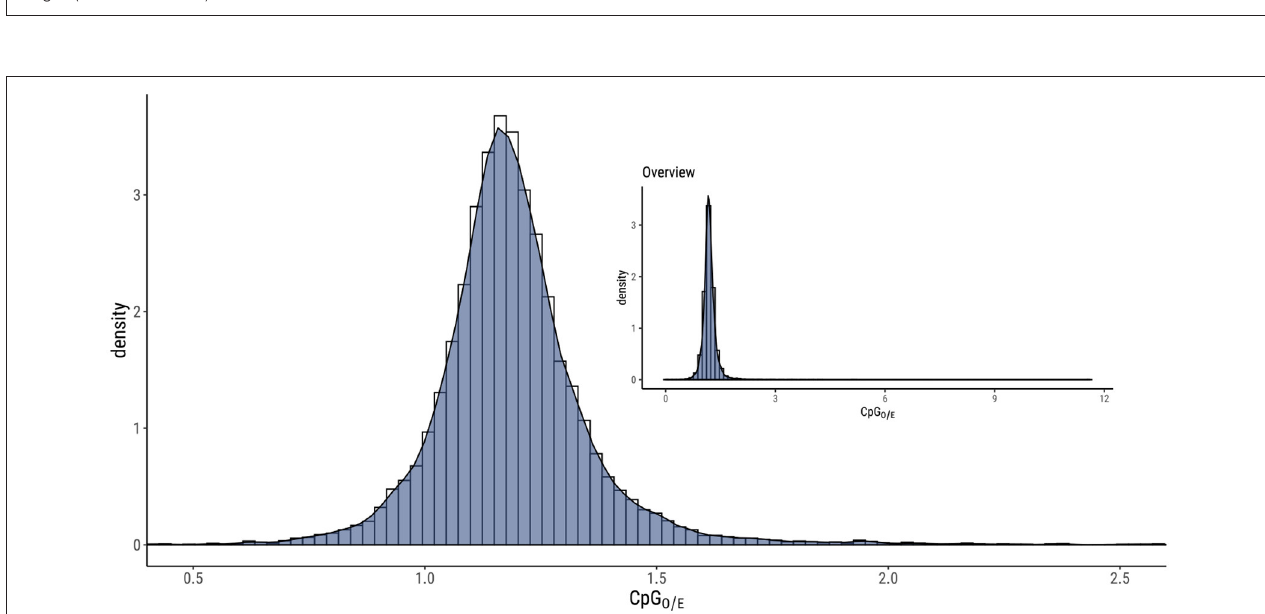
stage-specific over-representation, seven of which were related to reproduction and one involved in sensory perception ( Supplementary Table 6